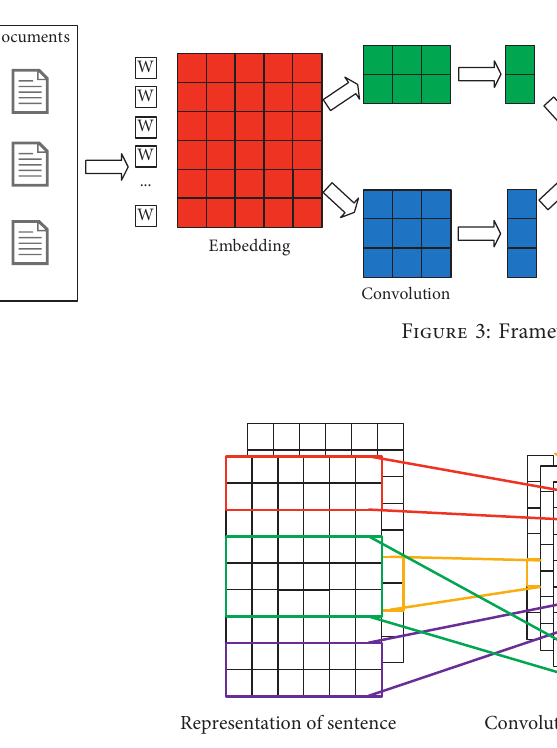
Figure 4: Text representation model.